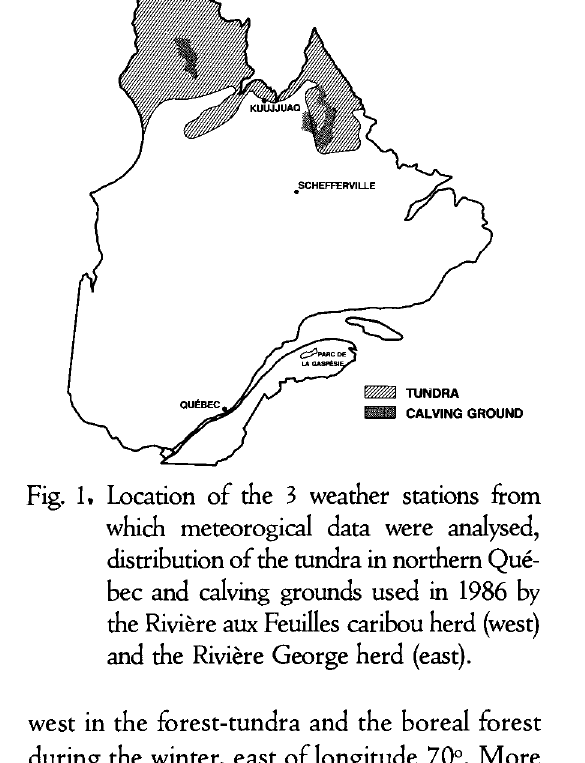
Fig. It Location of the 3 weather stations from which meteorogical data were analysed, distribution of the tundra in northern Qué bec and calving grounds used in 1986 by the Rivière aux Feuilles caribou herd (west) and the Rivière George herd